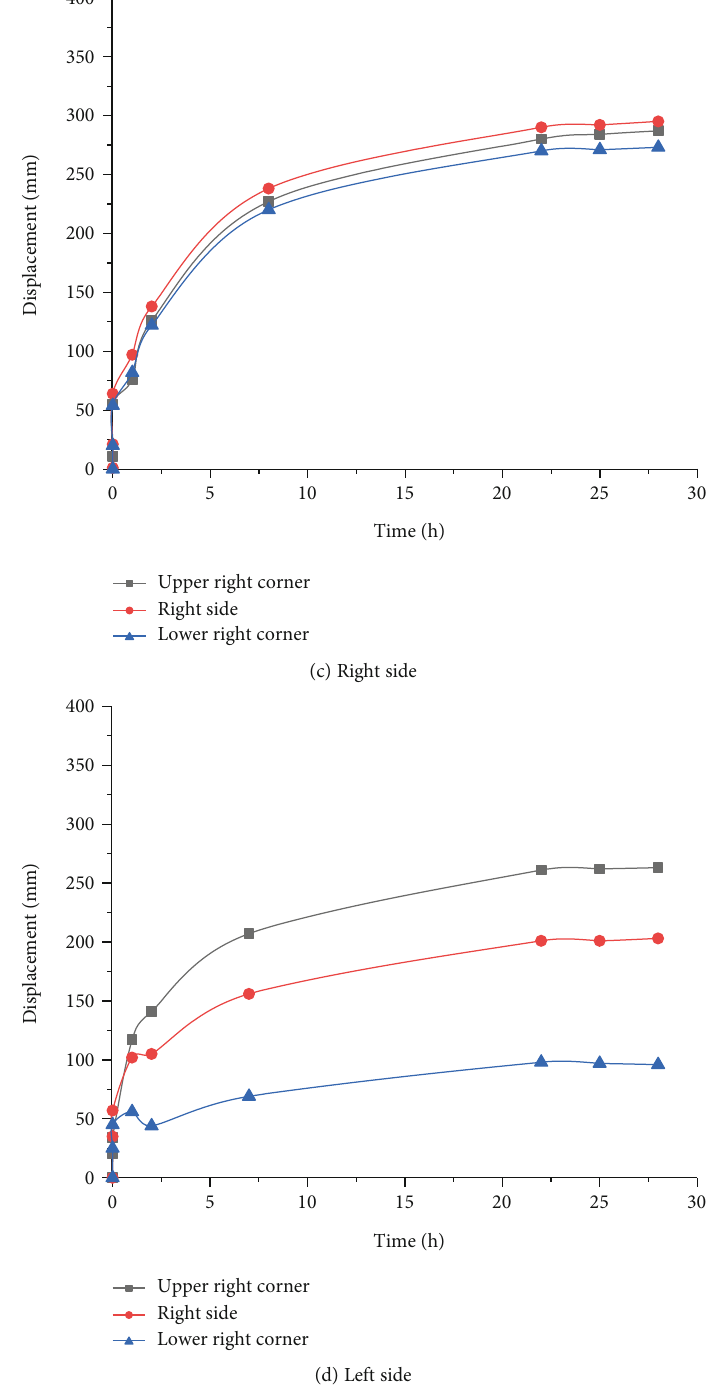
Figure 9: Displacement of surrounding rock in